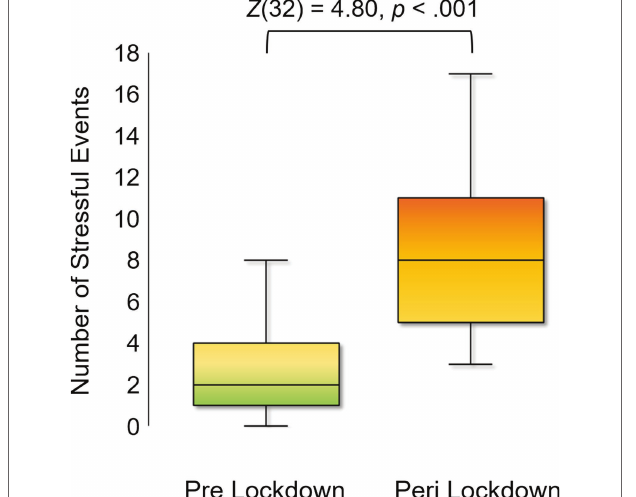
FIGURE 1 | Number of Stressors Endorsed before and after March 15, 2020. Box plots showing the distribution of stressful events endorsed my mothers in the six months prior to local lockdowns beginning (around March 15, 2020; “Pre-lockdown”), and in the time since local lockdowns began (“Post-Lockdown”). A Wilcoxon Z showed a statistically significant increase in the number of stressful events endorsed by mothers since lockdowns